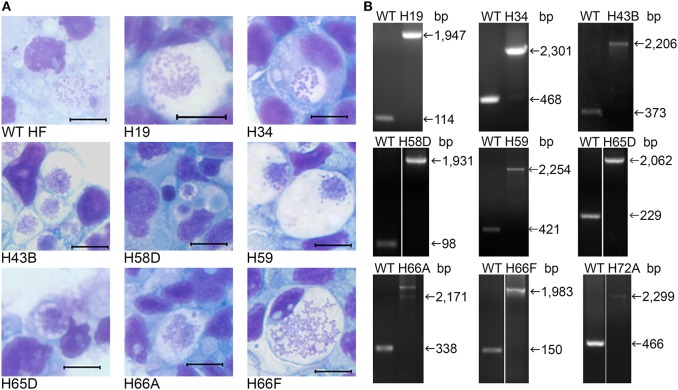
Infectivity of cloned HF Himar1 mutants in ISE6 tick cells. Cloned HF Himar1 mutants and WT HF cultured in ISE6 tick cells. (A) HEMA3 staining. Scale bar, 10 μm. (B) Insertion site-specific flank PCR confirming clonality of each mutant in tick cells.